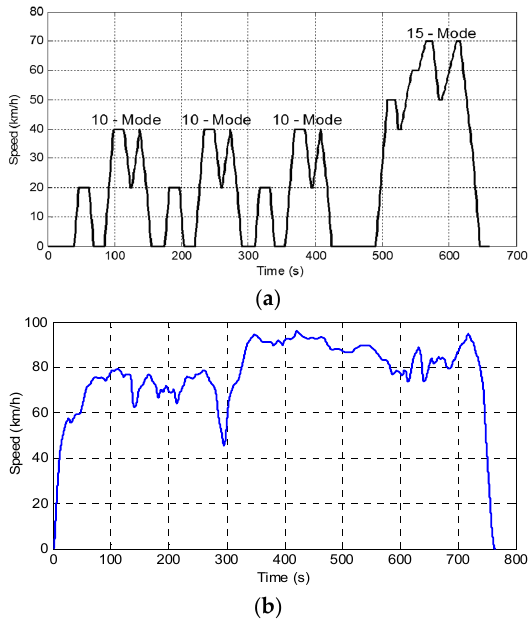
Figure 3. Velocity Reference Trajectories. ( a ) Japan 1015 Driving Cycle; ( b ) Highway Fuel Economy Test Driving Cycle.